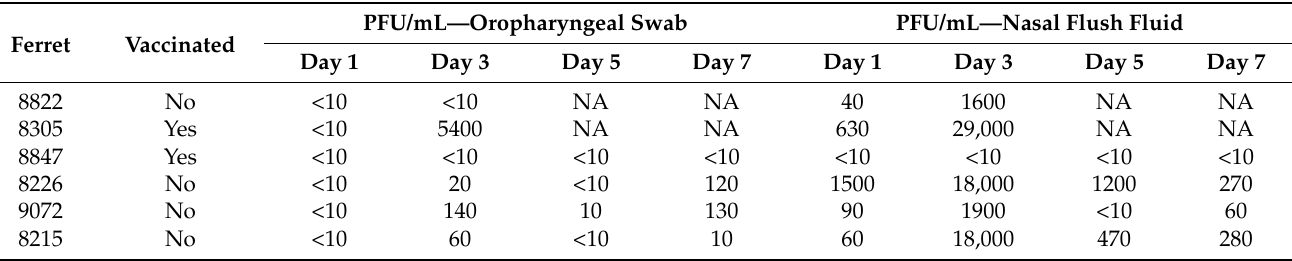
Table 2. Virus shedding in six black-footed ferrets following challenge with SARS-CoV-2, two of which had been vaccinated previously against the virus. Viral loads in oropharyngeal swabs and nasal flush fluids are quantified as plaque-forming units (PFU)/mL.